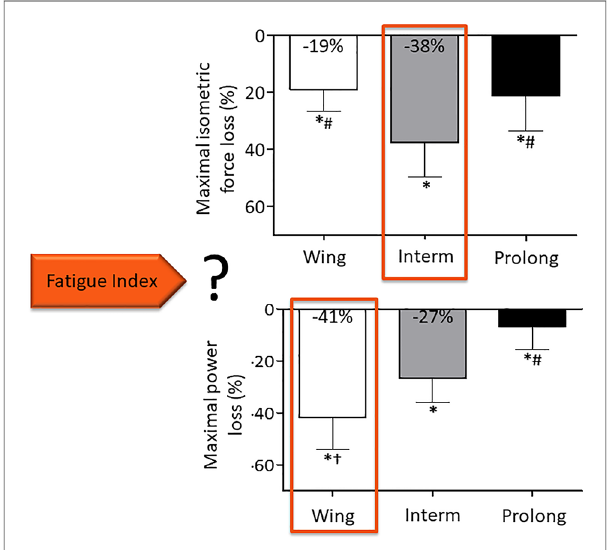
FIGURE 2 Neuromuscular fatigue depends on the index chosen. Adapted from (71). Wing: Wingate test, Interm: 10-min cycling exercise at a power output 5% above the respiratory compensation point, Prolong: 90-min cycling exercise at a power output 20% below the gas exchange